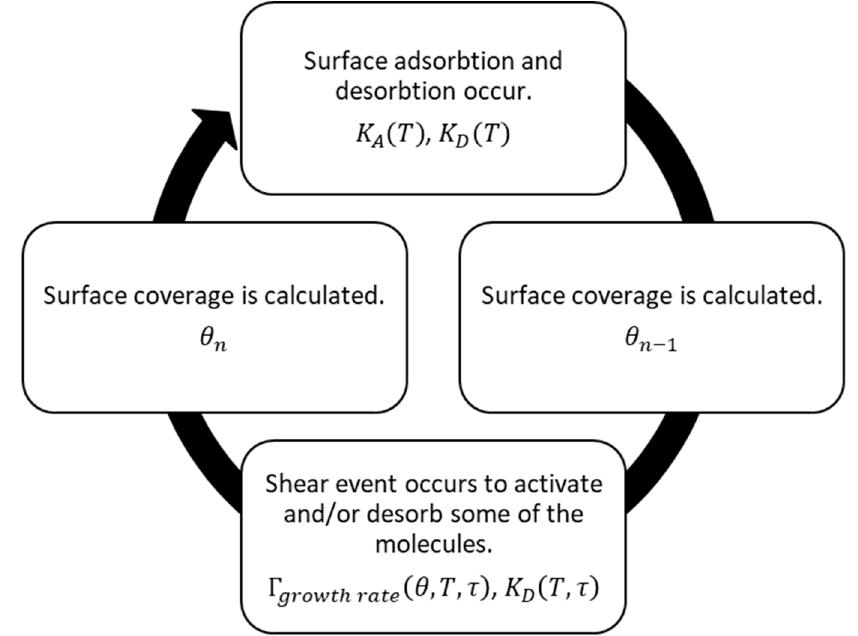
Figure 6. Cyclic process illustrating adsorption and activation of additives by a cyclic tribological event.